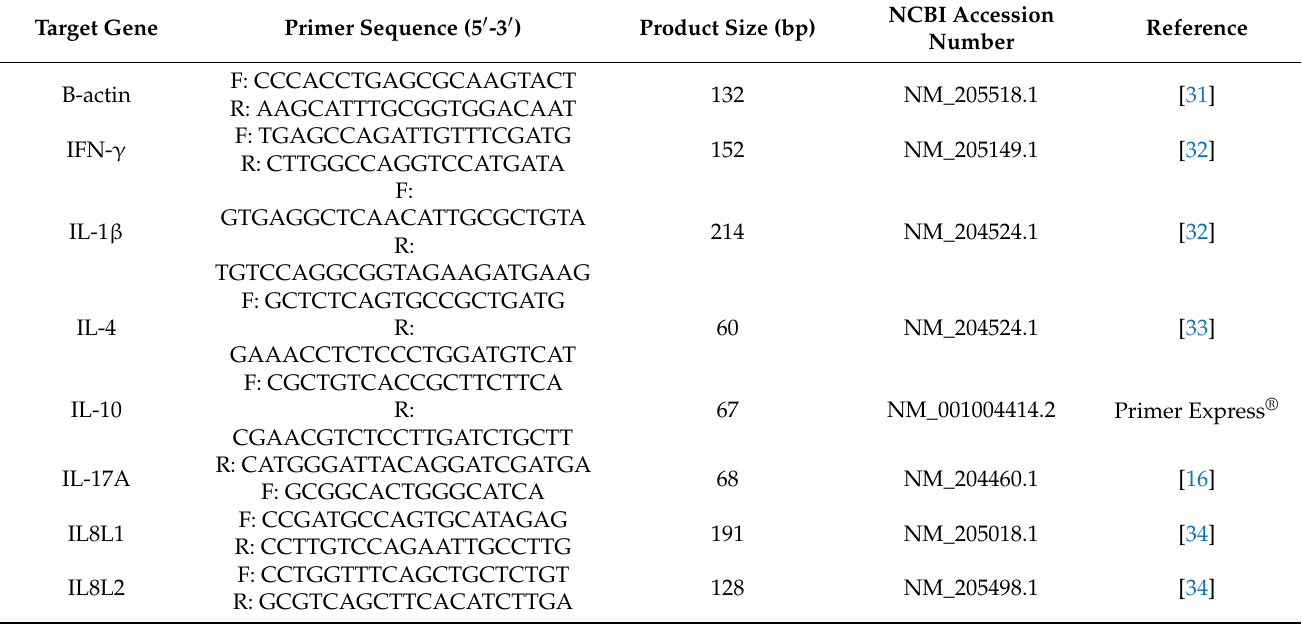
Table 1. Primer sequences for the gene expression determined by qPCR. Target